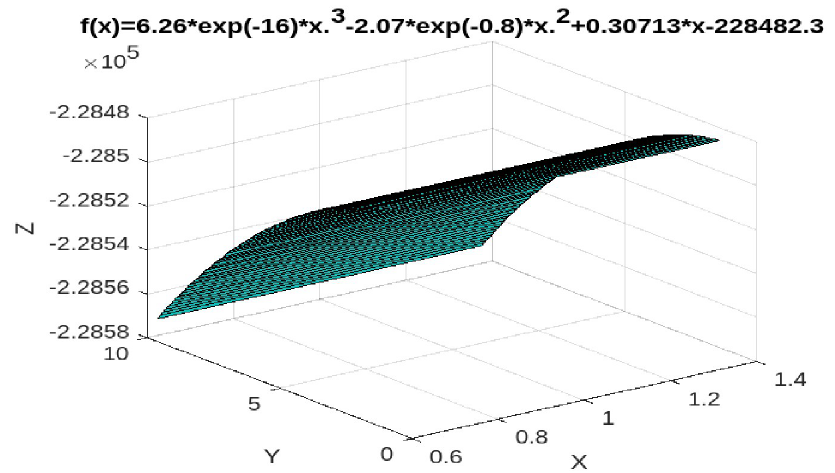
Fig 5. TTR-to-GDP threshold analyses, Taiwan,